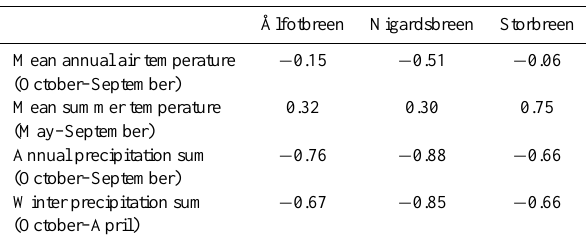
Table 5. Correlation coefficient of annual glacier melt for the model period